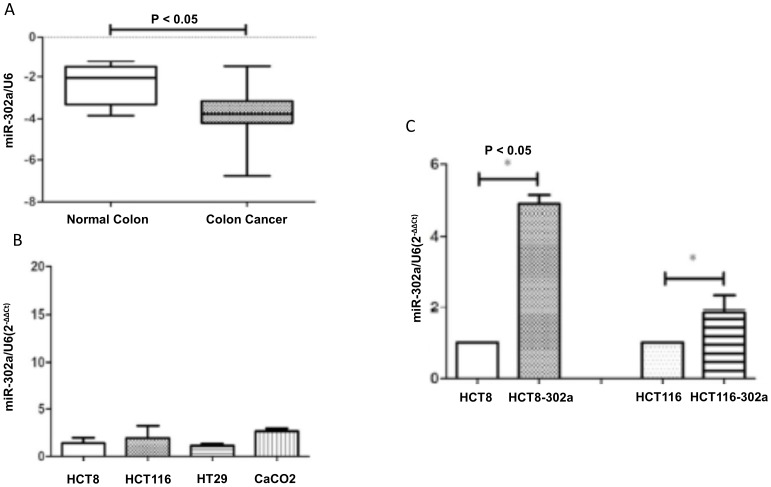
MiRNA-302a expression profiles in colon cancer tissue, normal prostate tissue, and colon cancer cells.(A) MiRNA-302a expression was downregulated in colon cancer tissue compared with normal colon tissue. (B) Low levels of miRNA-302a expression were detected in four human colon cancer cell lines, HCT8, HCT116, HT29, and CaCO2. (C) High levels of miRNA-302a expression were detected in HCT8 and HCT116 colon cancer cells stably expressing miRNA-302a (*P<0.05).